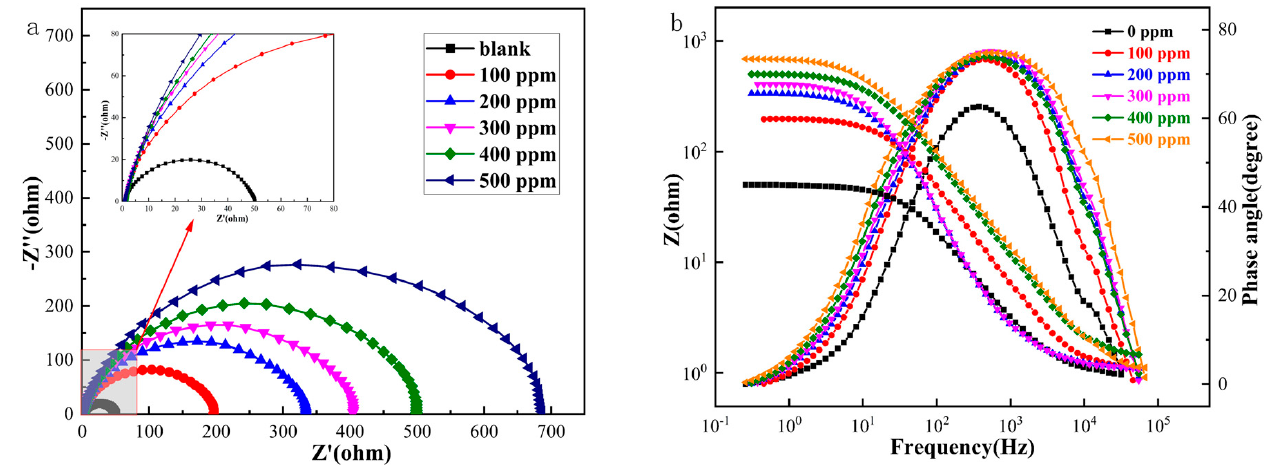
Figure 2. AC impedance spectrum of Q235 carbon steel in solution containing different. Table 1. EIS fitting parameters of Q235 carbon steel in solution containing different concentrations of Thy-2.